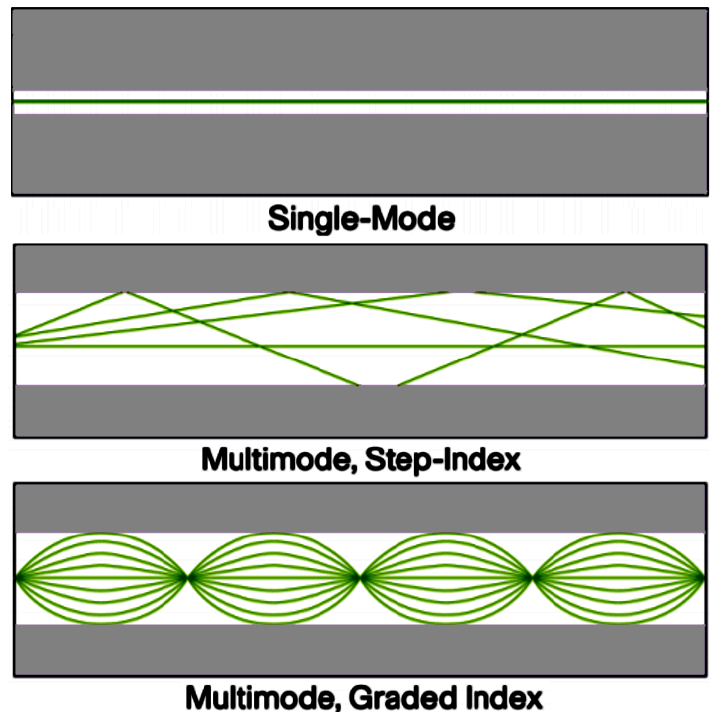
Figure 5. Multimode and single-mode fibers.